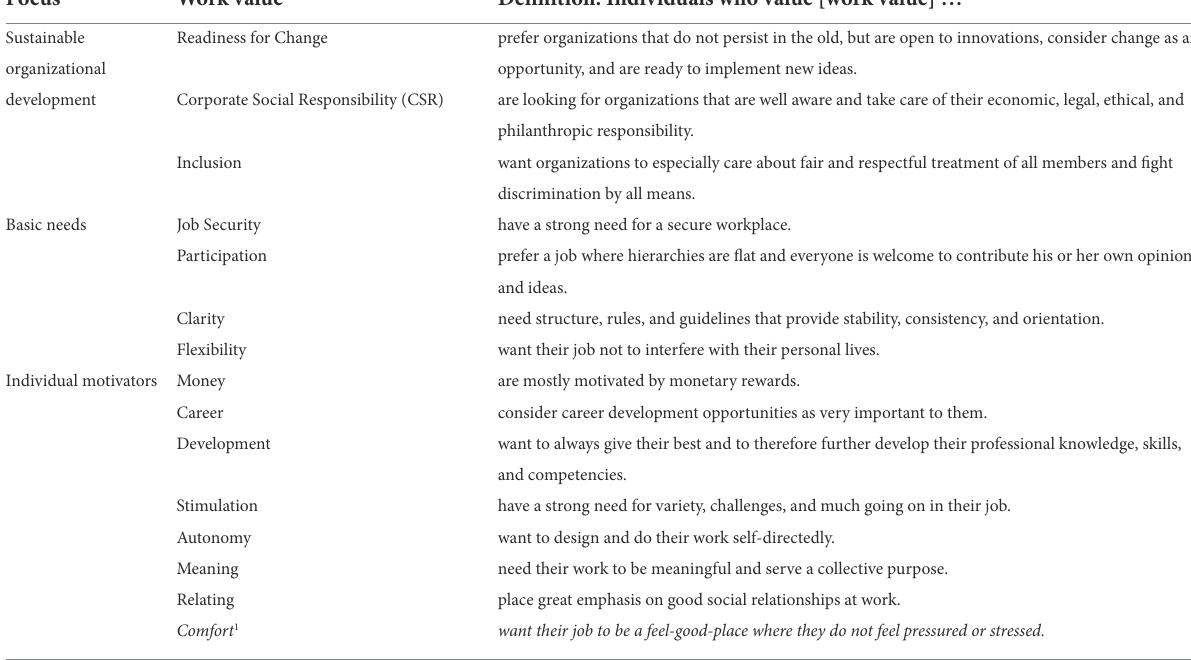
TABLE 1 Work Values Covered by the New Work Values Scale.